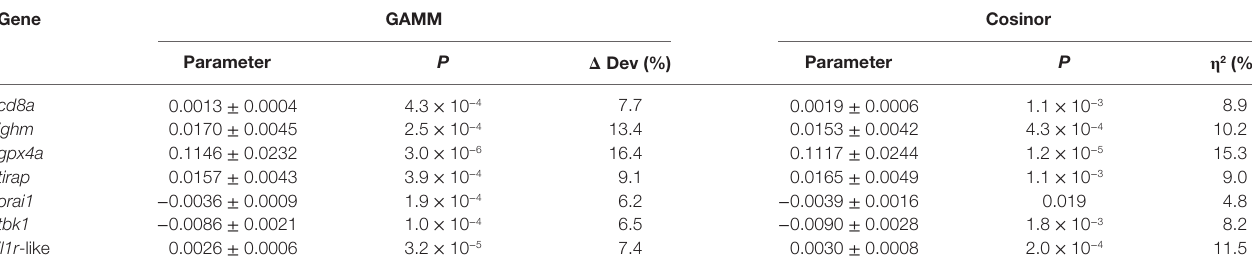
TaBle 3 | Thermal effects (7 vs 15°C) on the expression of individual genes in the laboratory experiment ( n = 120).